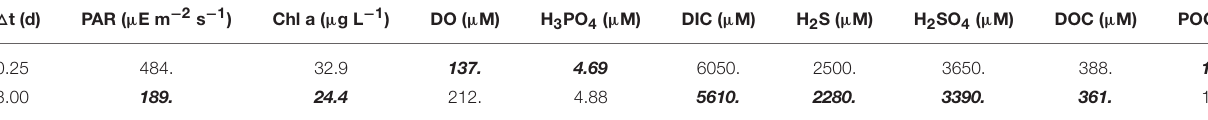
TABLE 3 | Root mean squared errors between model predictions and observations for the short (SIO, t = 0.25 d) and long (LIO, t = 3.0 d) interval optimizations. △ t (d)